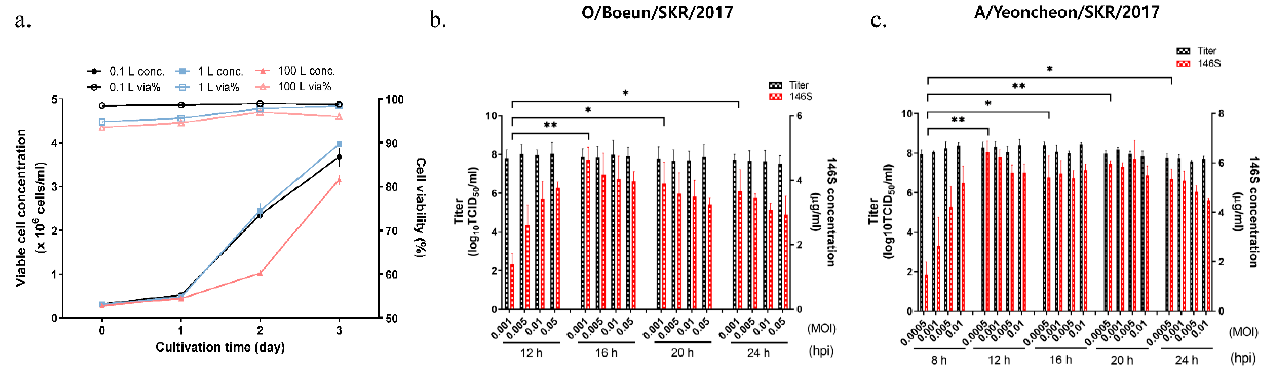
Figure 1. Optimization of the conditions for antigen production in a flask scale. ( a ) Comparison of cell growth curve during cultivation of BHK-21 suspension cell for 3 days in different volumes. Viable cell concentration (filled symbols) and cell viability (empty symbols) were estimated by Vi-cell RX at 0, 1, 2, and 3 days. Determination of optimal virus concentration and harvest time for ( b ) O/Boeun/SKR/2017 and ( c ) A/Yeoncheon/SKR/2017. BHK-21 suspension cells were grown up to 3 × 10 6 cells/mL for 3 days, inoculated with viruses at different MOIs. The samples were collected at 8 h or 12 h to 24 h post-infection. The data shown are representative of three independent experiments and are presented as the mean ± standard deviations (SD). The asterisks represent the statistical differences: *, p < 0.05; **, p <